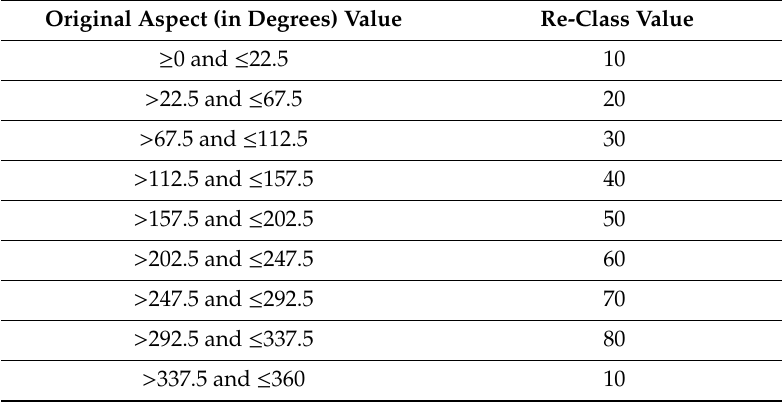
Table 2. Original aspect values (degrees) and assigned re-class values.